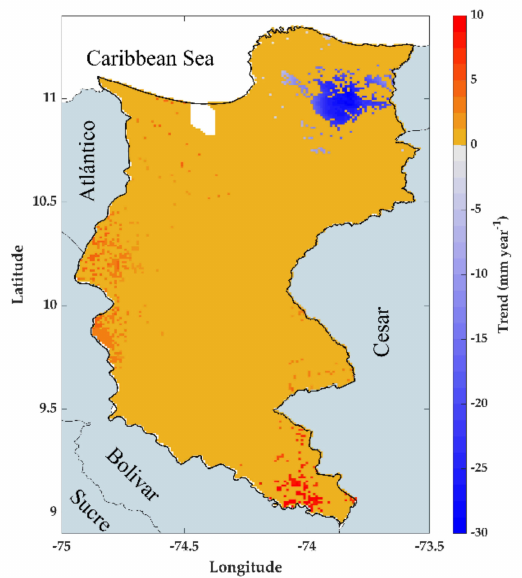
Figure 6. Trends for total annual precipitation in the Magdalena Department during the 1981–2018 period based on the CHIRPS v2.0